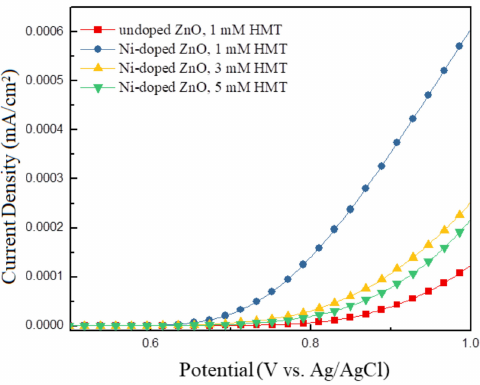
Figure 8. LSV curves for the undoped and Ni-doped ZnO NWLs with HTM concentrations of 1, 3, and 5